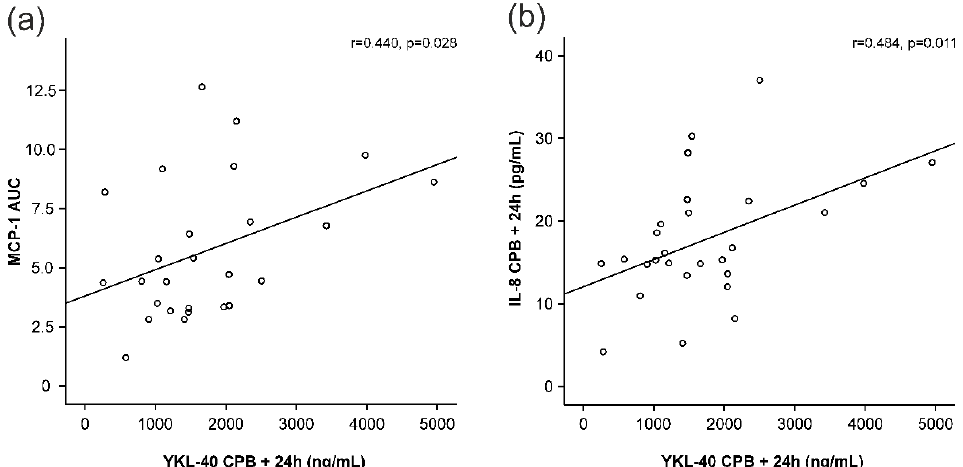
Figure 3. Correlations of peak YKL-40 levels (YKL-40 levels 24 h after the onset of cardiopulmonary bypass, CPB) to areas under curve (AUC) of monocyte chemotactic protein-1 (MCP-1, ( a )) and interleukin-8 (IL-8, ( b )) levels 24 h after the onset of cardiopulmonary bypass (CPB). Spearman’s correlation was calculated (r). p < 0.05 was considered statistically significant.